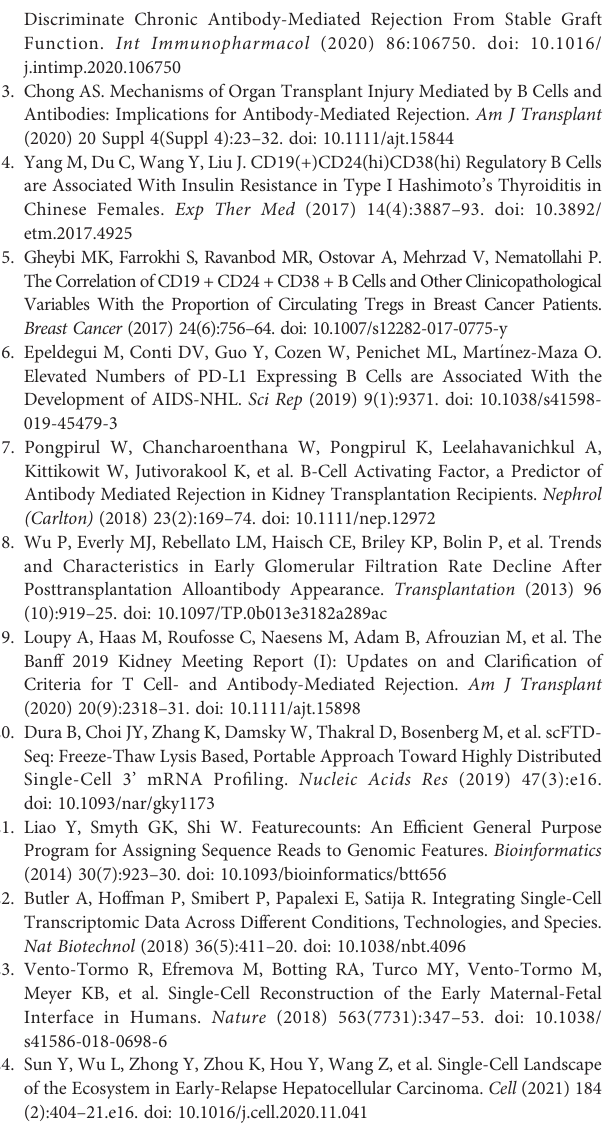
Supplementary Table 5 | GO and KEGG enrichment in CD8 effector T cell subsets. Supplementary Table 6 | GO and KEGG enrichment in CD8_MAI T subsets. Supplementary Table 7 | GO and KEGG enrichment in gd T cell subsets. Supplementary Table 8 | List of Marker genes for B cells subtype subdivision. Supplementary Table 9 | DEGs in each B cell subsets from cABMR and control subjects shown in heatmap. Supplementary Table 10 | GO and KEGG enrichment in Naive B cell subsets. Supplementary Table 11 | GO and KEGG enrichment in Plasma cell subsets. Supplementary Table 12 | D Ct values of related genes in qRT-PCR